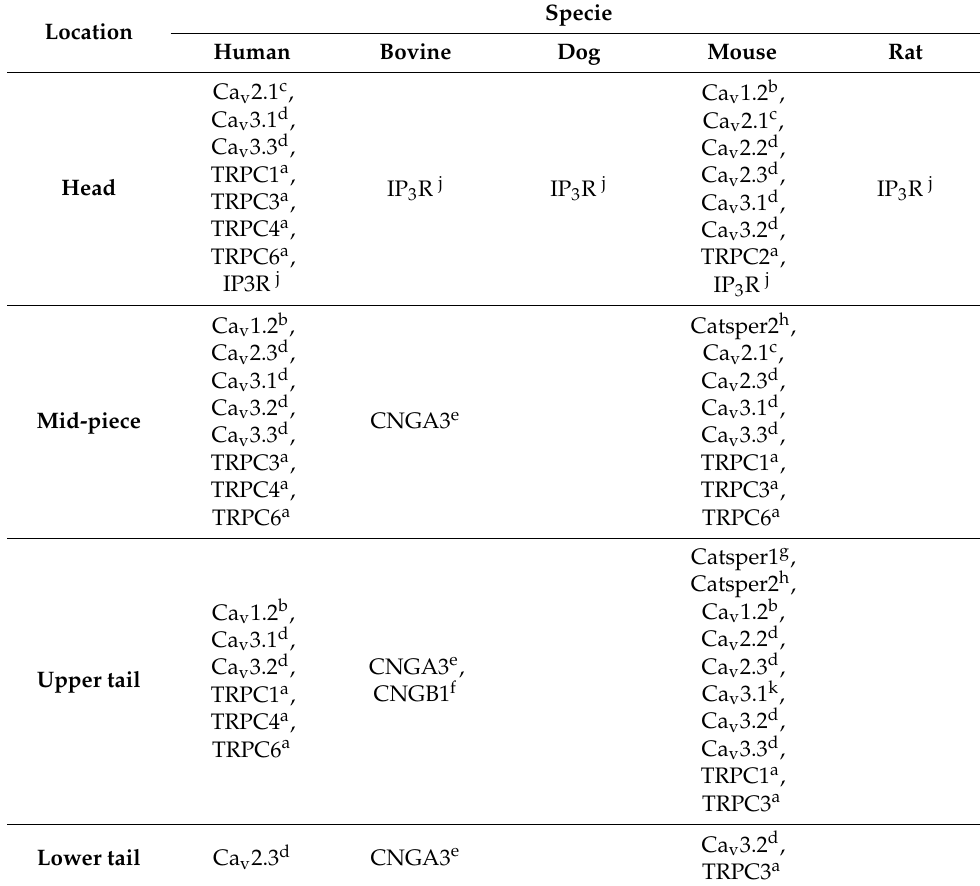
Table 1. Ion and voltage-gated channels of mammalian sperm. Location